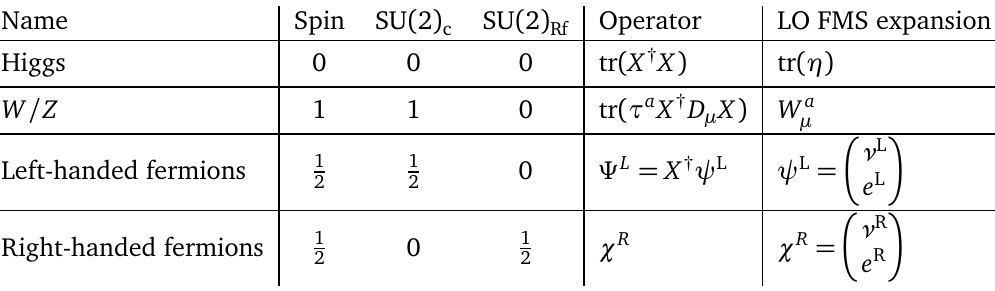
Table 1: The physical states, their quantum numbers, and their leading order contri- bution in the FMS